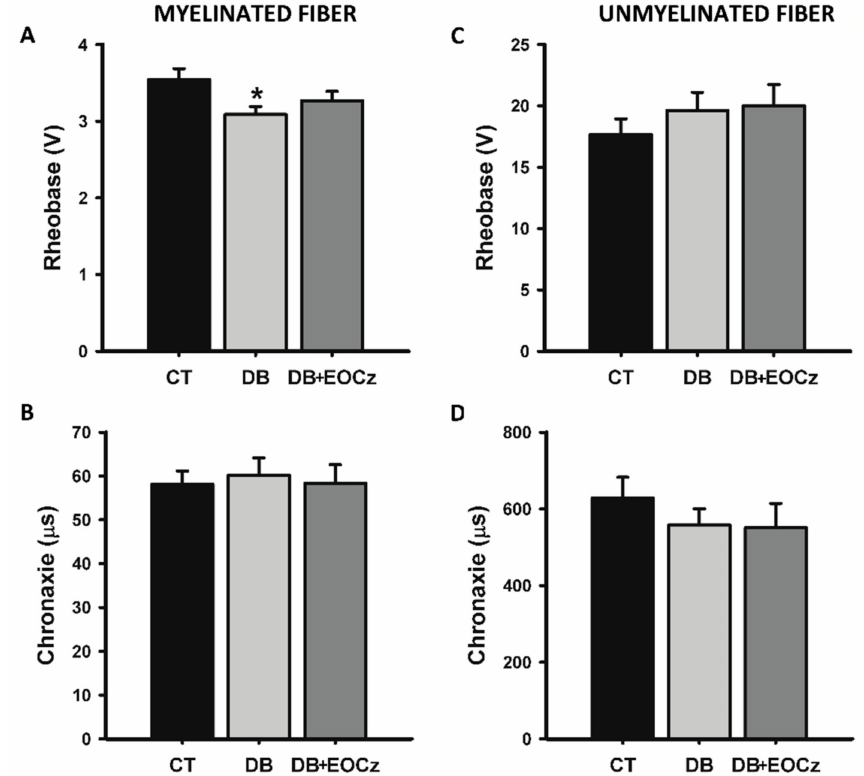
Figure 5. Effect of EOCz treatment on DM-induced alterations of excitability of myelinated and unmyelinated vagal fibers. Rheobase and chronaxie are shown on panels ( A , B ), respectively, for myelinated, and on panels ( C , D ) for unmyelinated fibers. CT, control; DB, diabetic; DB + EOCz, diabetic treated with EOCz. Data are presented as mean ± E.P.M and * p < 0.05, when compared to control (one-way ANOVA, followed by the Holm–Sidak